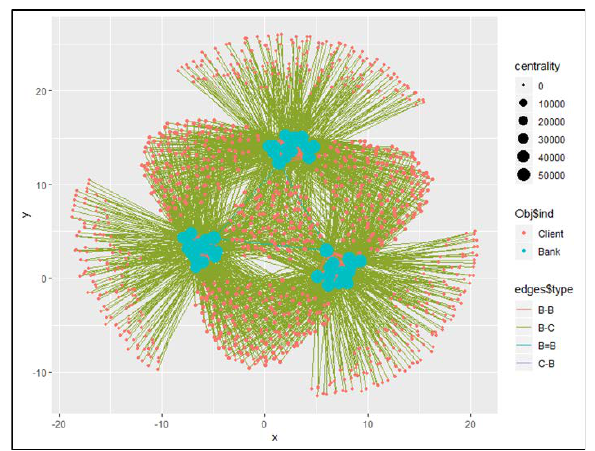
Fig. 2 . Graph of electron money turnover participant with random links in crash-test scheme.